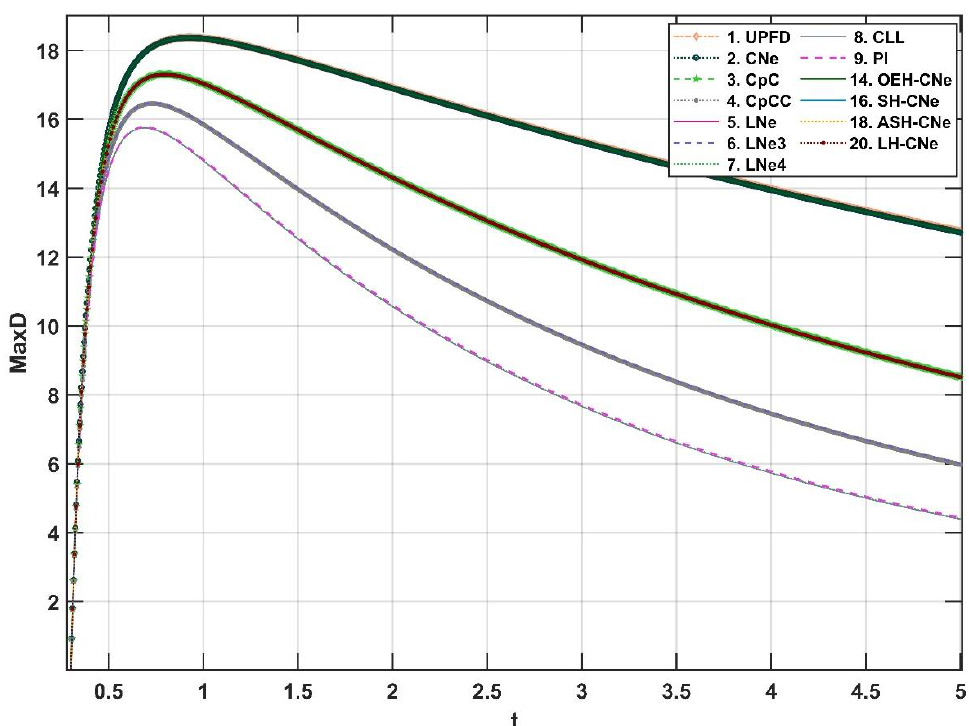
Figure 13. The evolution of the maximum errors as a function of the physical time t for the slowly converging methods in Experiment 5. The used time step size is ∆ t = 4.7 · 10 − 3 .